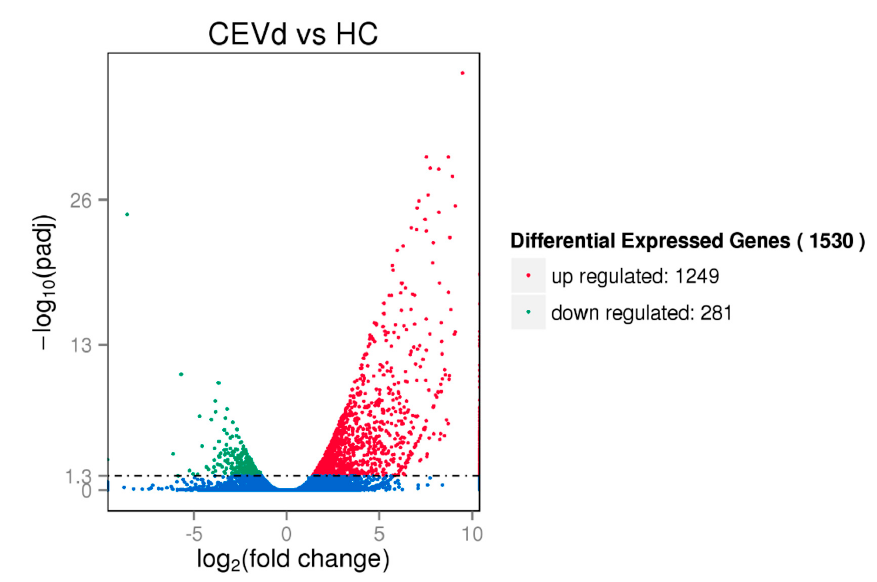
Figure 3. Volcano map of the differential genes. Genes with significant differential expression were indicated by red dots (upregulated) and green dots (downregulated). Genes with no significant differential expression were represented by blue dots.